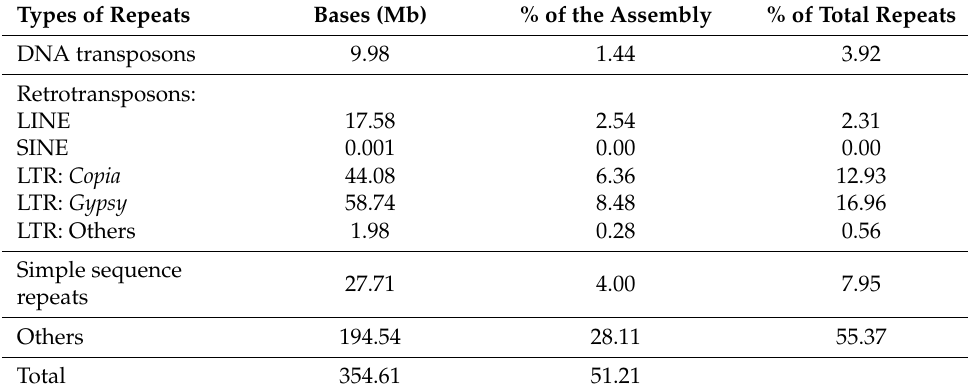
Table 2. Repeat contents in M. speciosa genome.